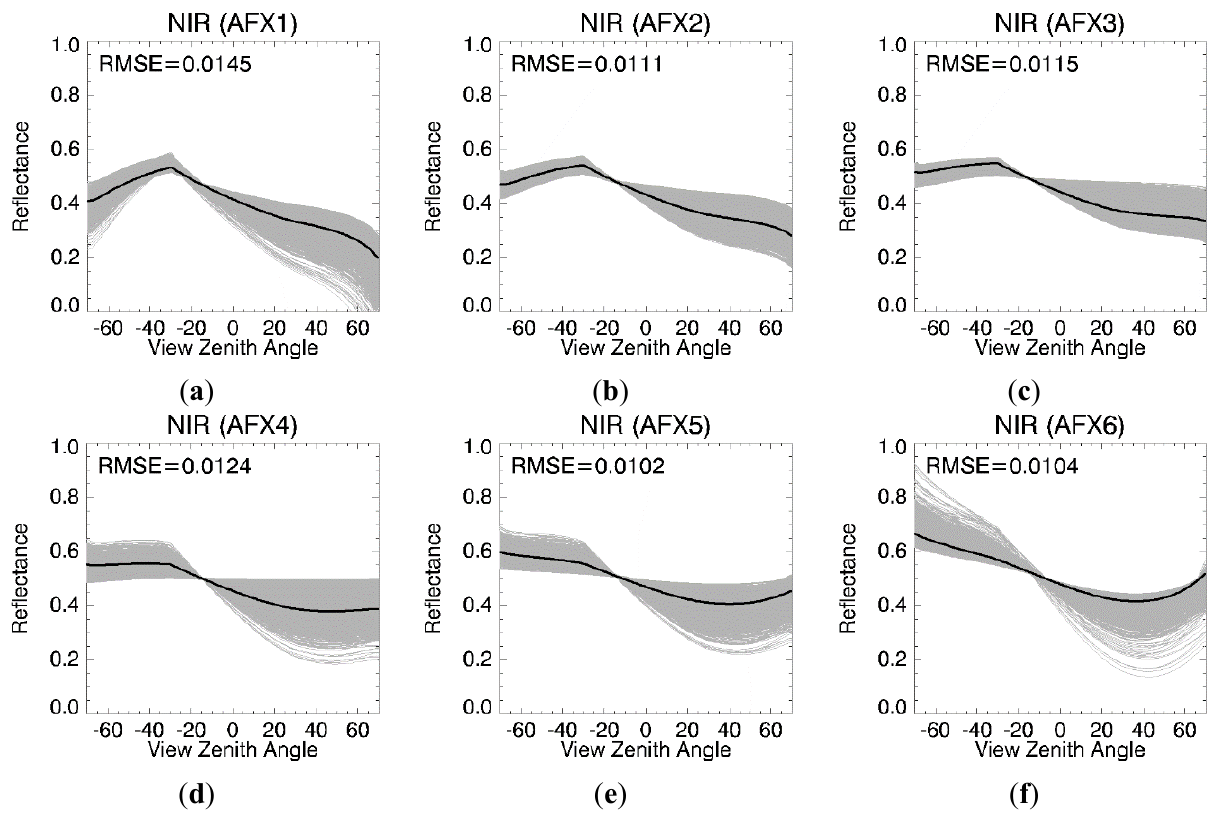
Figure 3. BRDF shapes of the normalized MODIS BRDFs of five-year time-series data of 1000 randomly sampled pixels for tile H20v11 and the corresponding BRDF archetype in the principal plane at a solar zenith angle of 30° for the MODIS NIR band. ( a – f ) refer to the first–sixth BRDF